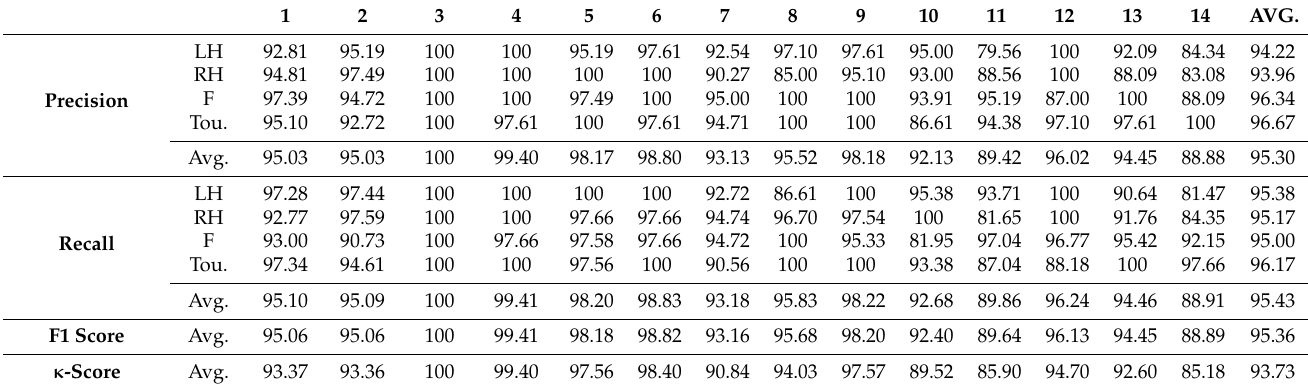
Table 9. Precision, recall, F1 score, and κ -score on the HGD using MBEEGNet.